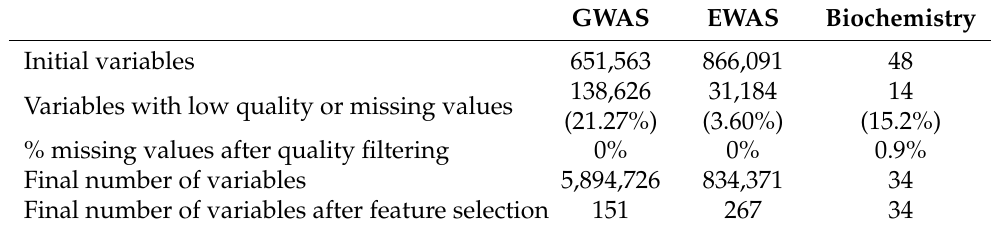
Table 1. Summary table of the three different datasets considered in this study, showing the main features considered in each pre-processing